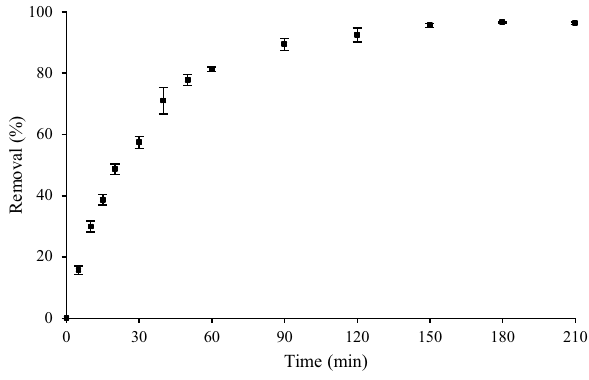
Fig. 4 Effect of solid adsorbent concentration on PAR